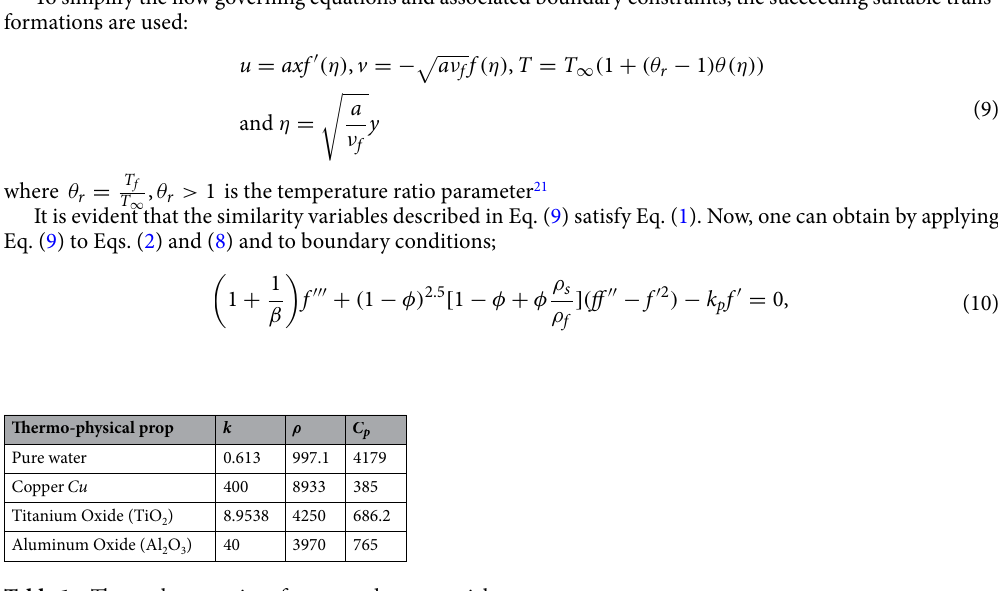
Table 1. Thermal properties of water and nanoparticles.